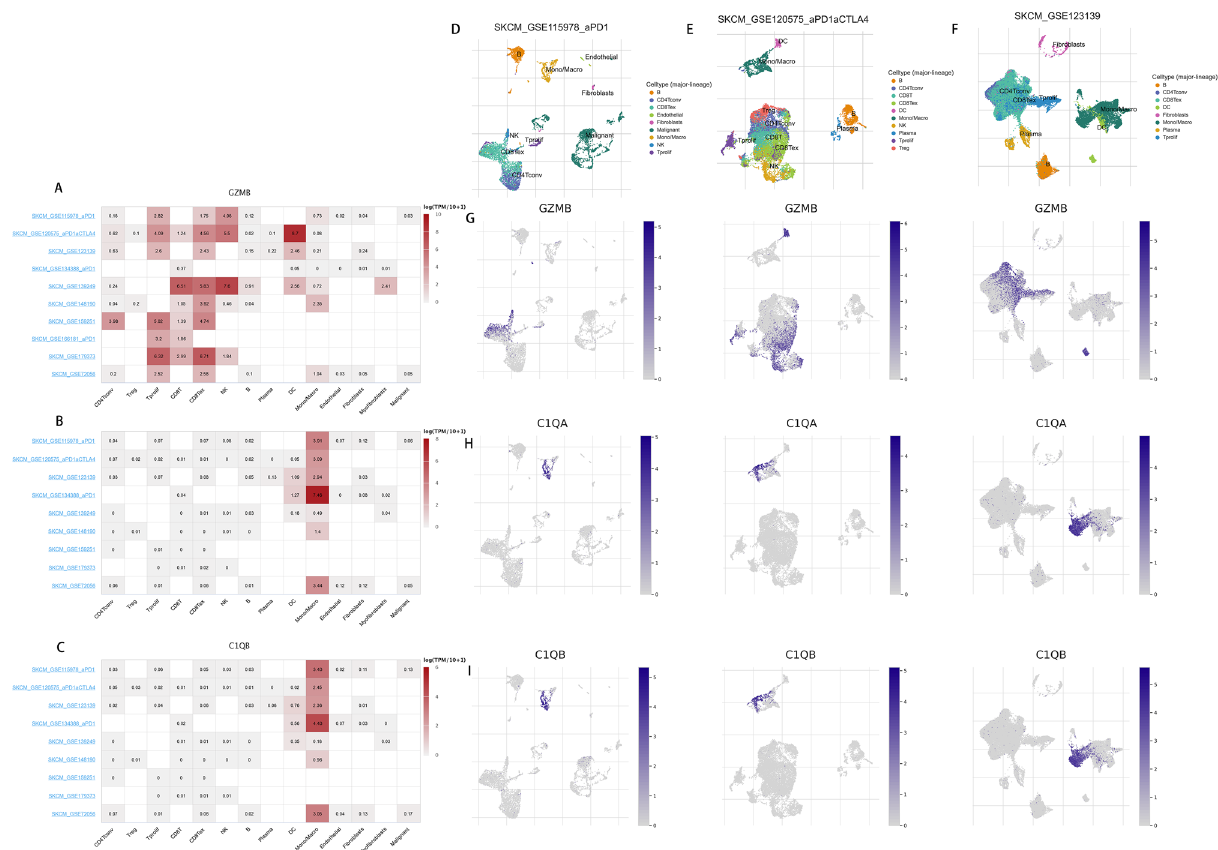
Figure 8. ( A – C ) Summary of C1QA , C1QB and GZMB expressions of 14 cell types in 9 SKCM single cell datasets. (D-F) Scatter plot showed the distributions of different cell types of the SKCM single cell dataset. ( G – I ) Scatter plot showed the C1QA , C1QB and GZMB expressions levels of cells in the SKCM single cell dataset. This figure was generated using the Tumor Immune Single-cell Hub (TISCH) web tool (http:// tisch. comp- genom ics. org/ docum entat ion/) 18